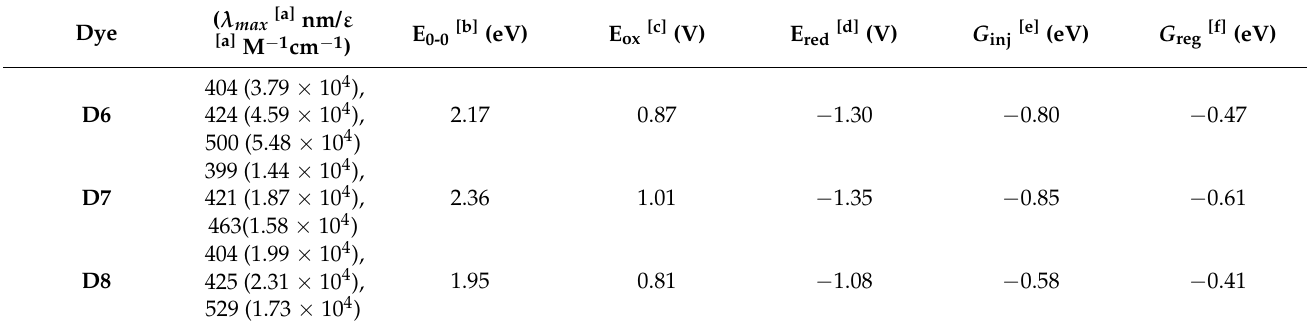
Figure 2. ( a ) Absorption spectra of dyes in DCM solution. ( b ) Absorption spectra of dyes on TiO 2 film. Table 1. Photophysical and Electrochemical properties of the